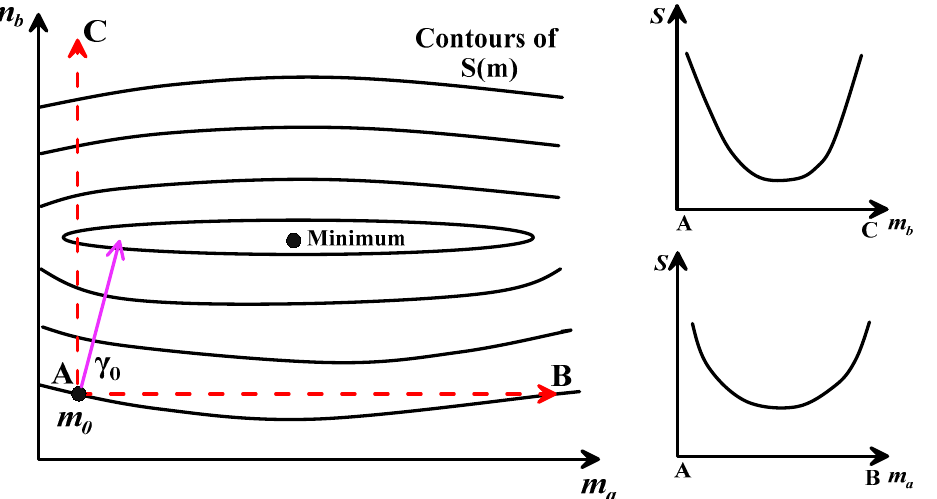
Figure 1. A contour plot of S (m) which is a function of two parameters of different physical dimensions [14].